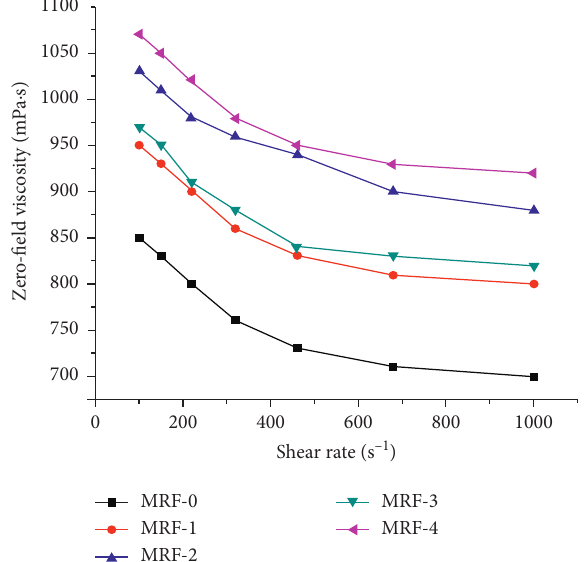
Figure 11: Zero-field viscosity of the